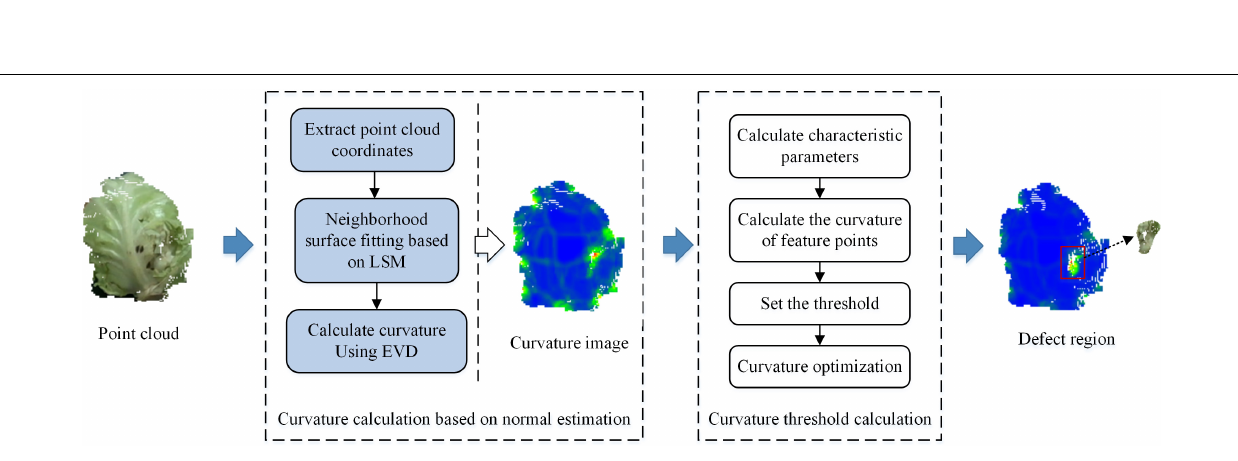
FIGURE 7 | The point distribution histogram before and after subsampling: (A) the point cloud before subsampling and (B) the point cloud after subsampling.